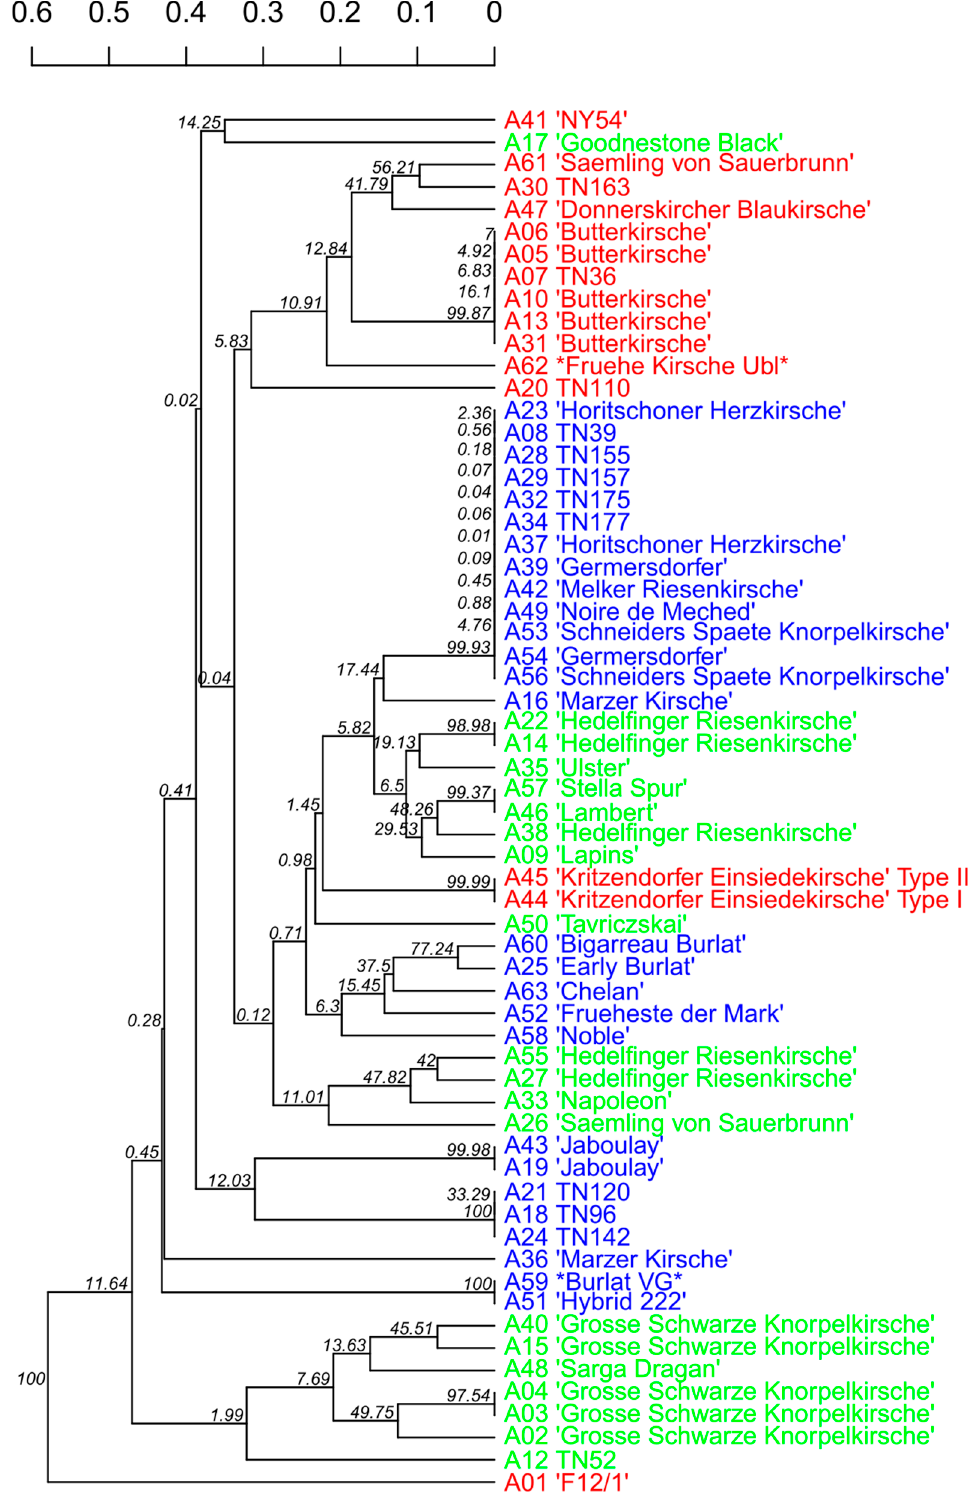
Figure 4. Dendrogram based on SSR data, Nei’s distance, bootstrapping (10,000), unweighted pair group with arithmetic means (UPGMA); color code according to DAPC clusters: 1: red, 2: green, 3: blue.